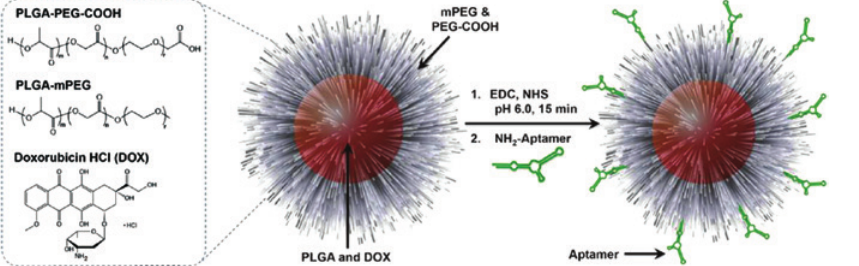
Figure 3: Preparation of aptamer-functionalized, DOX-loaded NPs via nanoprecipitation of amphiphilic block copolymers, followed by carbodiimide-mediated aptamer coupling. As a targeted drug delivery system, these nanoparticles were roughly 100–125 nm in diameter and have a high encapsulated efficiency for DOX. Reprinted by permission from Weigum et al.